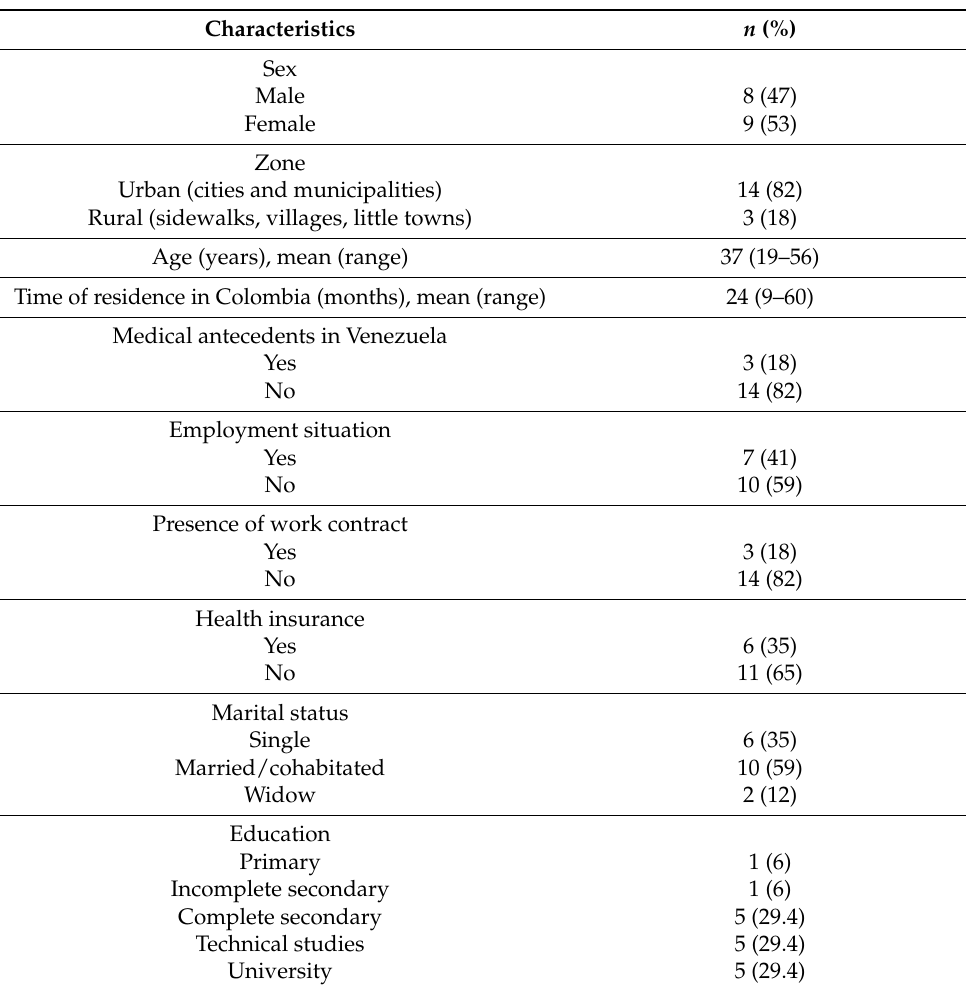
Table 1. Sociodemographic characteristics of the Venezuelan participants in Medell í n, Colombia ( n = 17). Characteristics n (%) Sex Male 8 (47) Female 9 (53) Zone Urban (cities and municipalities) 14 (82) Rural (sidewalks, villages, little towns) 3 (18) Age (years), mean (range) 37 (19–56) Time of residence in Colombia (months), mean (range) 24 (9–60) Medical antecedents in